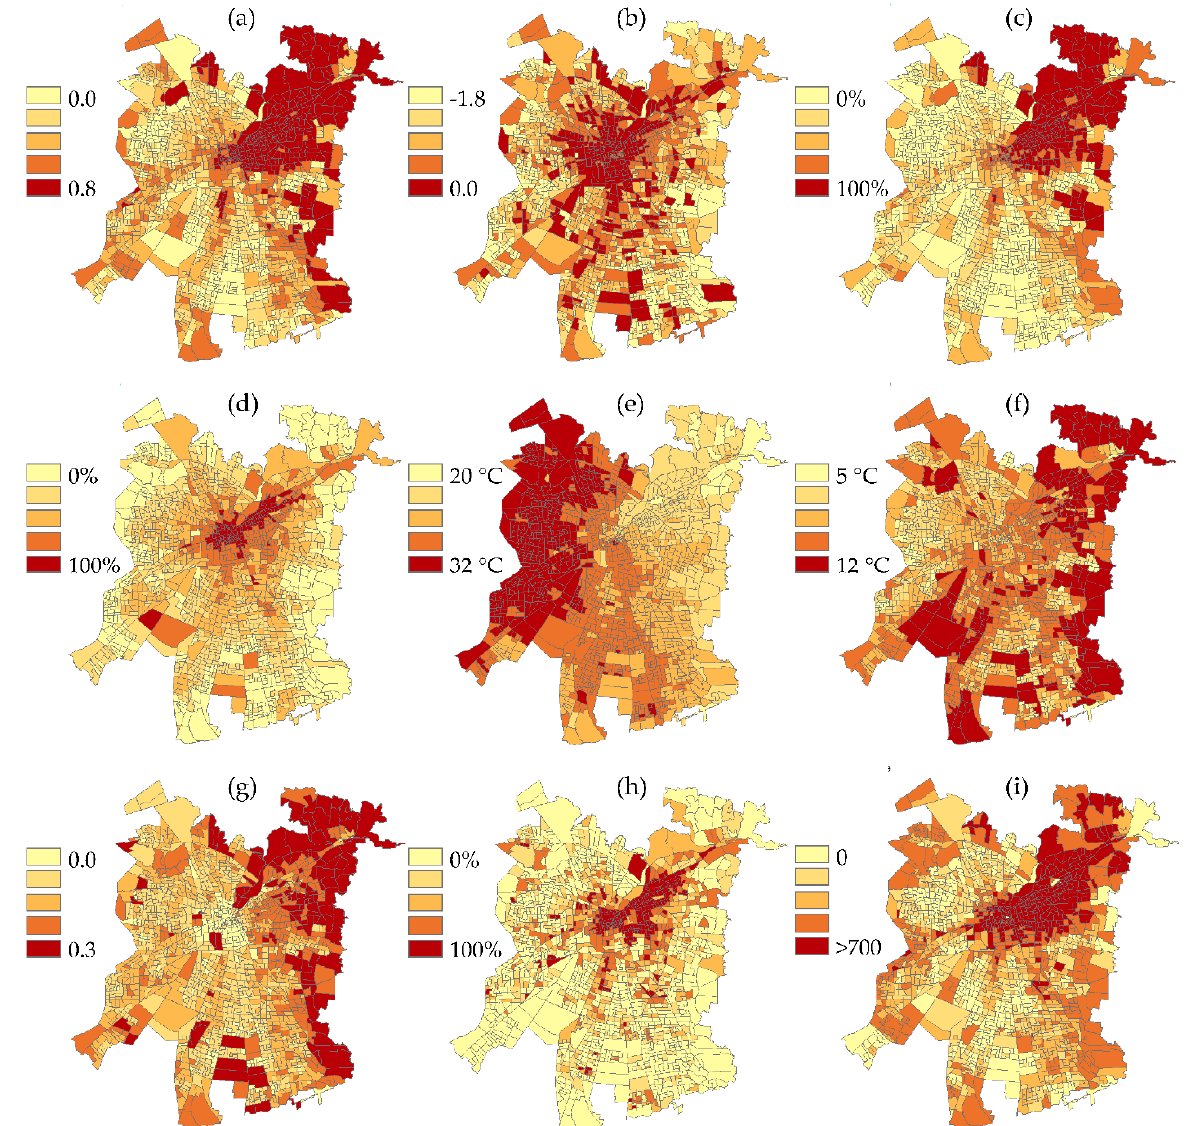
Figure 4. Description of the independent variables, indicating their minimum and maximum values, used in the models to explain the inside temperature of homes in the metropolitan area of Santiago: ( a ) SMTI; ( b ) land ‐ use heterogeneity; ( c ) percentage of professionals; ( d ) percentage of households without children; ( e ) 2017 annual thermal amplitude; ( f ) 2017 winter LST; ( g ) 2017 NDVI; ( h ) percentage of flats; and ( i ) average values of land prices expressed in US$/m 2 .